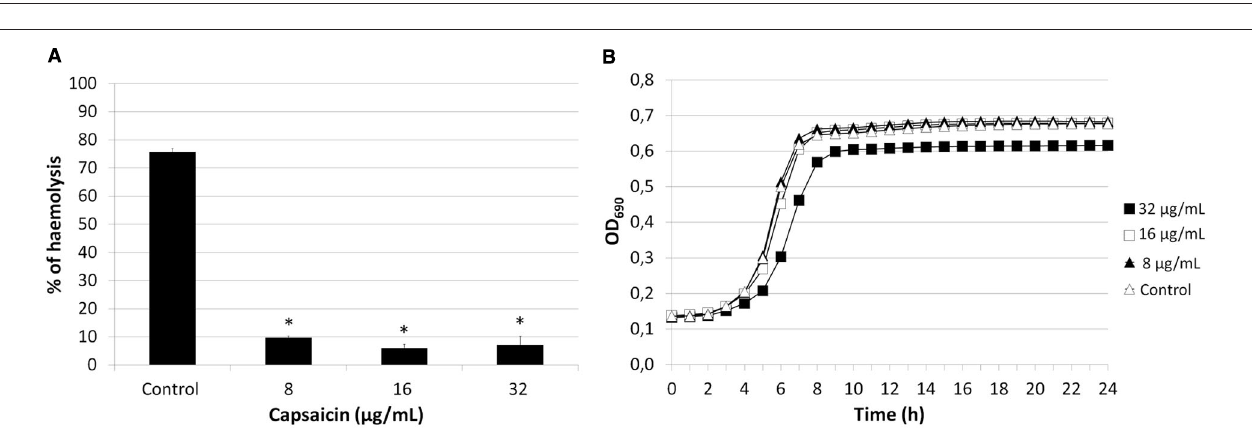
FIGURE 3 | Giemsa-stained A549 monolayers infected with strain SP1070 grown in presence of capsaicin sub-MICs. Streptococci adherent to A549 monolayers in the absence (A) and presence of 8 m g/mL of capsaicin (1/16 (cid:2) MIC) (B) . (Magnification: (cid:2) 1000; scale bar: 10 m m).